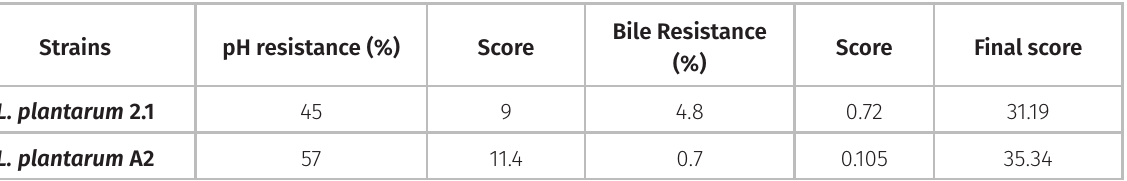
Table IV. Final scores per strain, based on the percentage values of survival after TGI and on the established coefficients. Strains pH resistance (%) Score